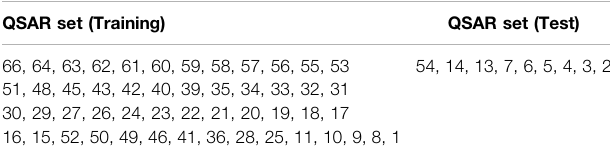
TABLE 4 | Training set where the random seed was 0, keeping actives and inactive in the training set where grid sampling is equal to 1.00 Å, maximum PLS factor was 1 and the model type is